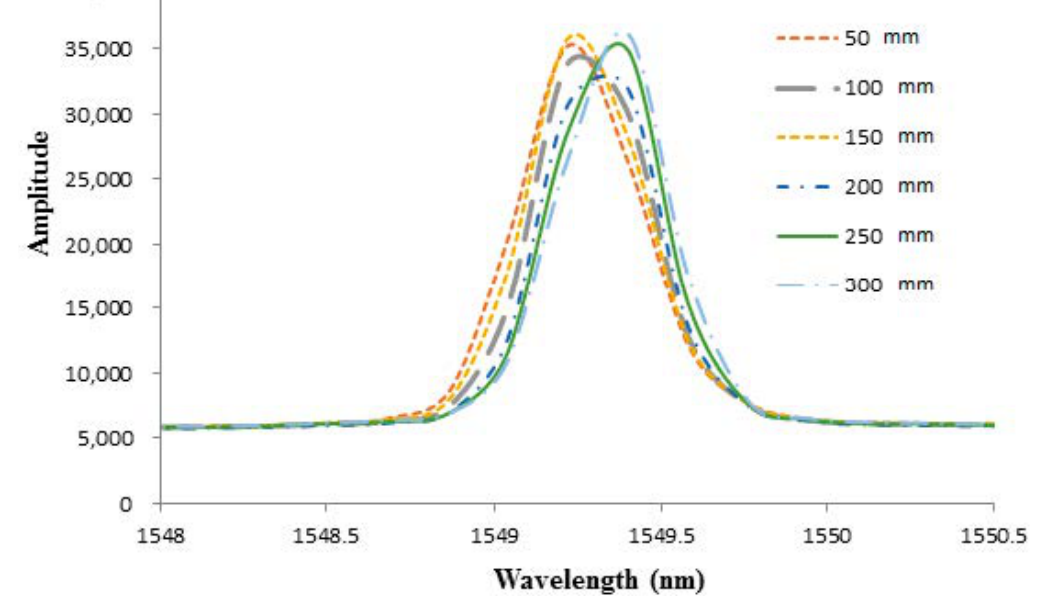
Figure 10. Optical spectra of Bragg wavelength reflected from the FBG sensor under various water levels with diaphragm thickness of 1.0 mm.